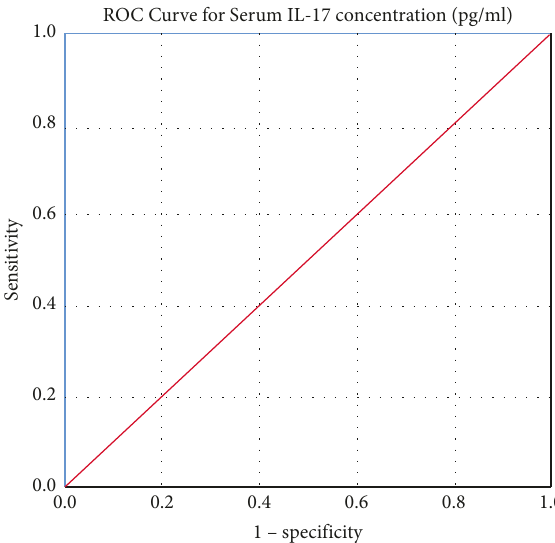
Figure 2: A ROC curve analysis for IL-17 concentration as a discriminator of COVID-19 patients. Table 3: IL17 F alleles and genotypes in the stud COVID-19 patients ( n � 132) and healthy controls ( n � 135). IL17F n